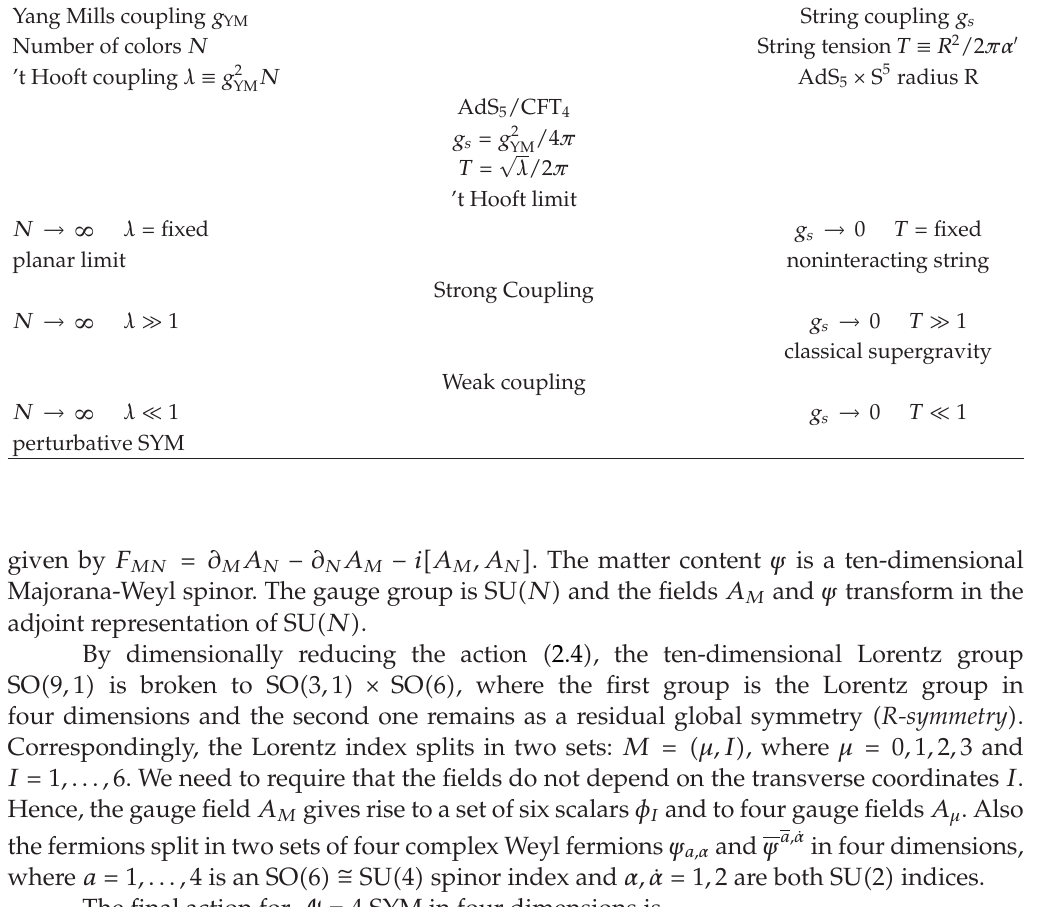
Table 1: Summary of the contents and parameters involved in AdS 5 /CFT 4 duality. Gauge theory String theory Yang Mills coupling g YM String coupling g